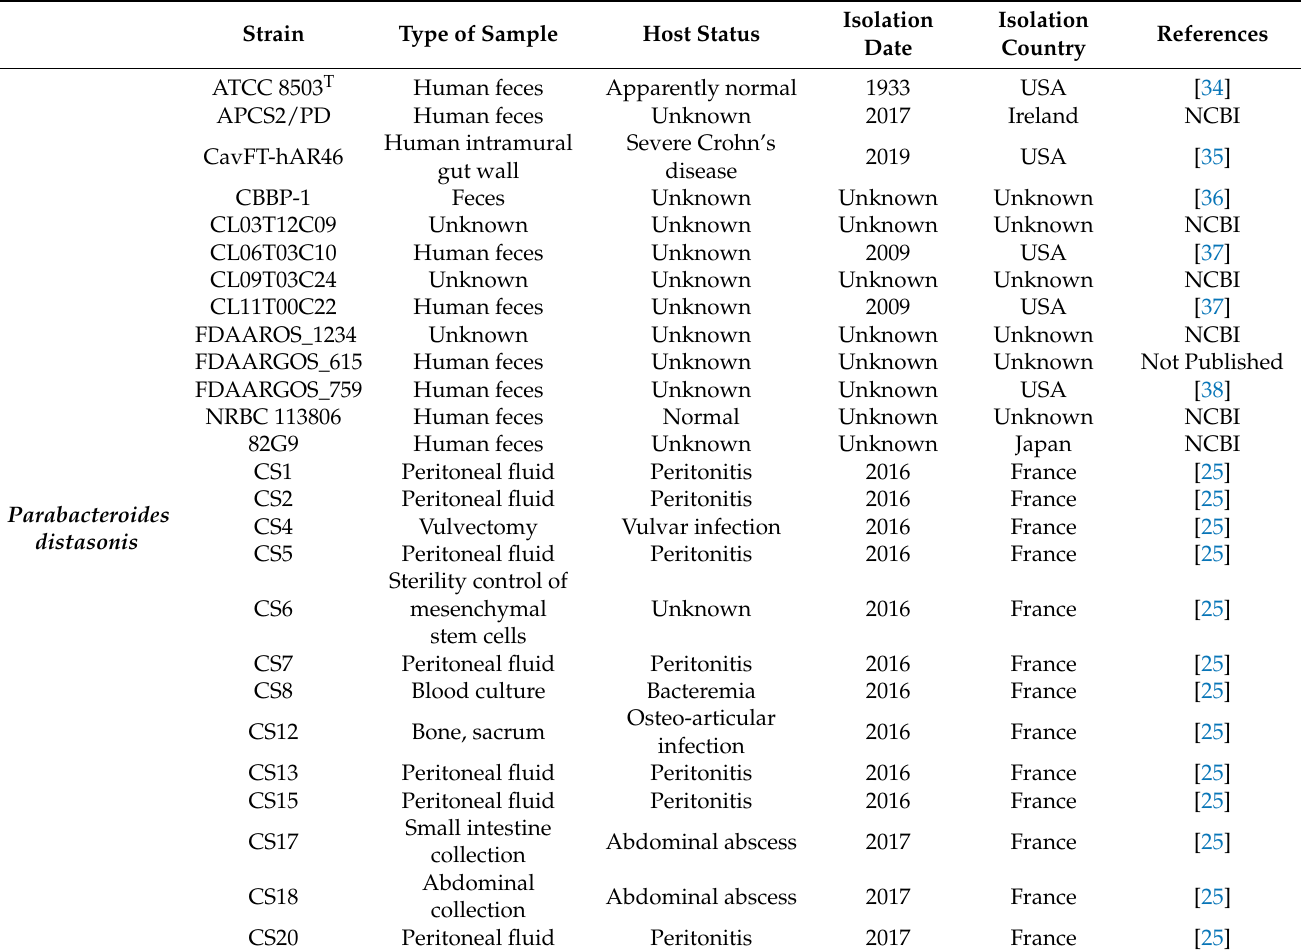
Table 1. P. distasonis strain